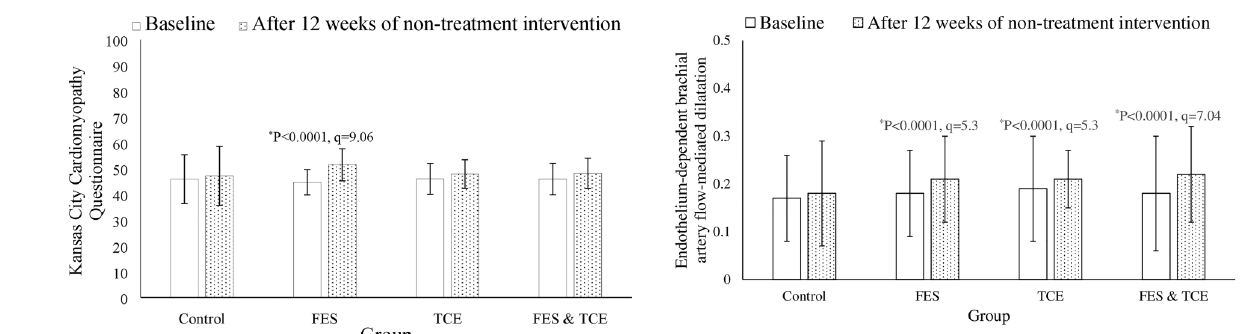
Figure 2. Effects of interventions on the Kansas City Cardiomy- opathy Questionnaire scores. RM-MANOVA followed by Tukey ’ s post hoc test was used for statistical analysis. Data are reported as means ± SD at baseline and after 12 weeks of non- pharmacological interventions. *P o 0.05 compared to the control group. FES: functional electrical stimulation of lower limb muscles; TCE: Tai Chi exercise.